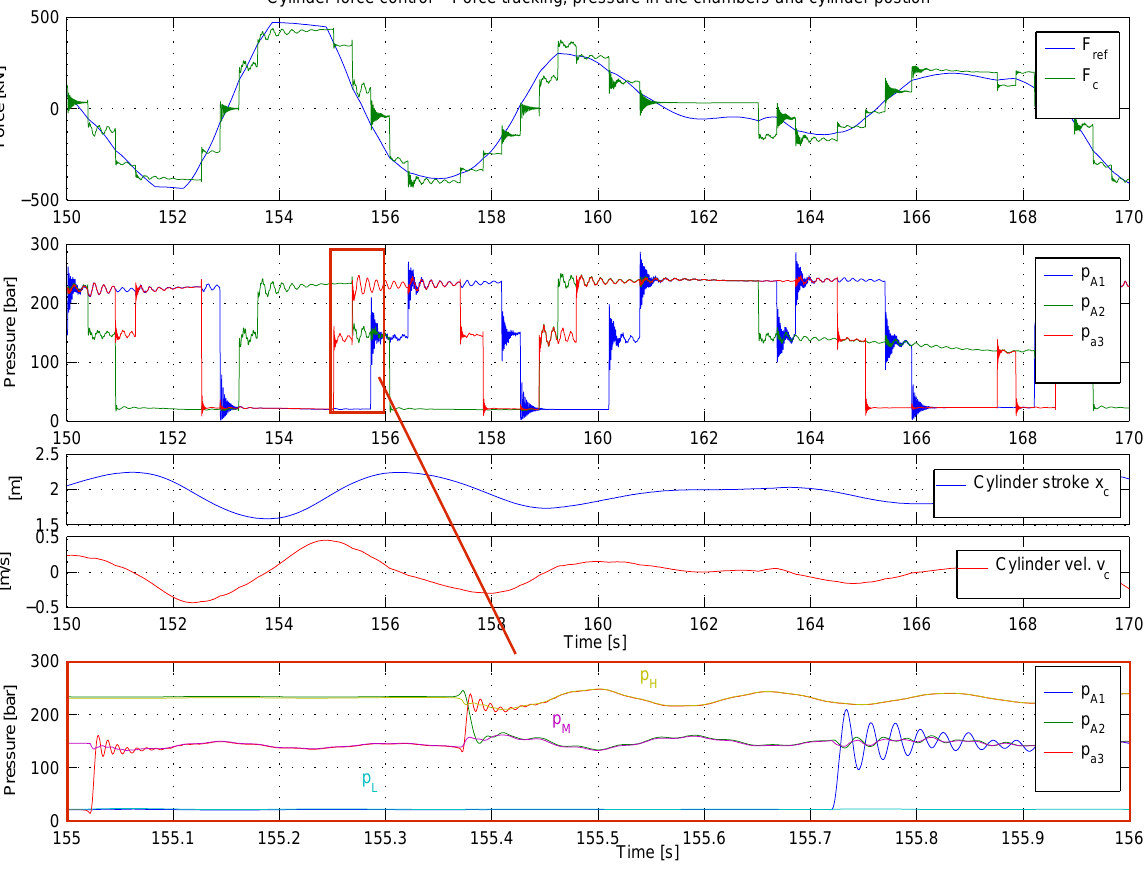
Figure 29. Force tracking of cylinder.